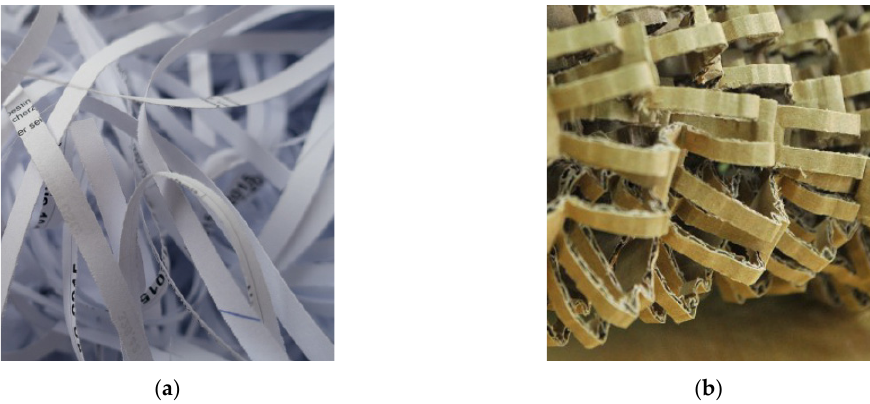
Figure 4. The grades of recovered paper: office wastepaper ( a ), chopped corrugated paperboards ( b ).